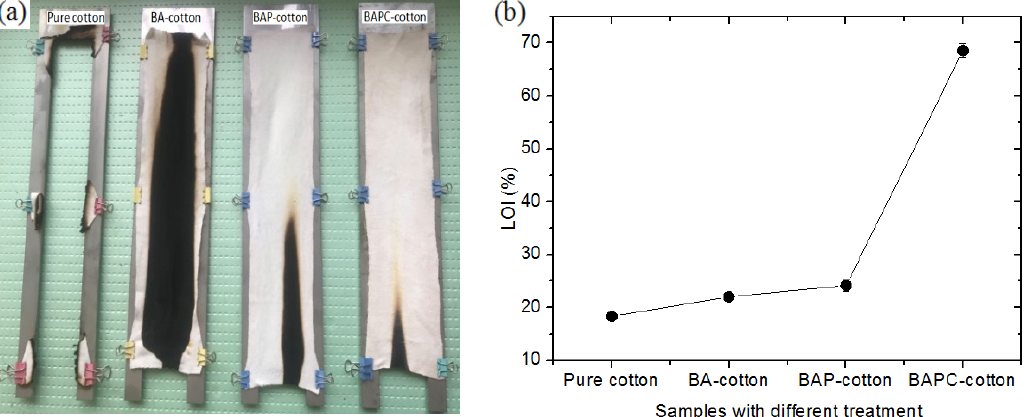
Figure 7. ( a ) Digital images of the cotton fabric with different treatment after vertical flame testing and ( b ) LOI curve of samples with different treatment.